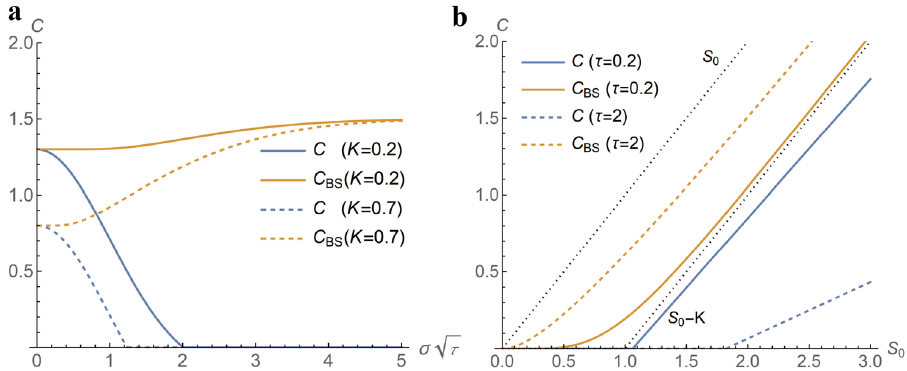
Fig. 3 The median C and the mean C BS (Black–Scholes). a C and C BS for K = 0.2 and 0.7 are T ( S 1.5 plotted against 𝜎 0 = and r = 0 ). b C and C BS for √ T = 0.2 and T = 2 are plotted against S 0 ( r = 0.2 , K = 1 and 𝜎 = 1 ). The BS formula C BS gives concave curves between S 0 and S 0 − K